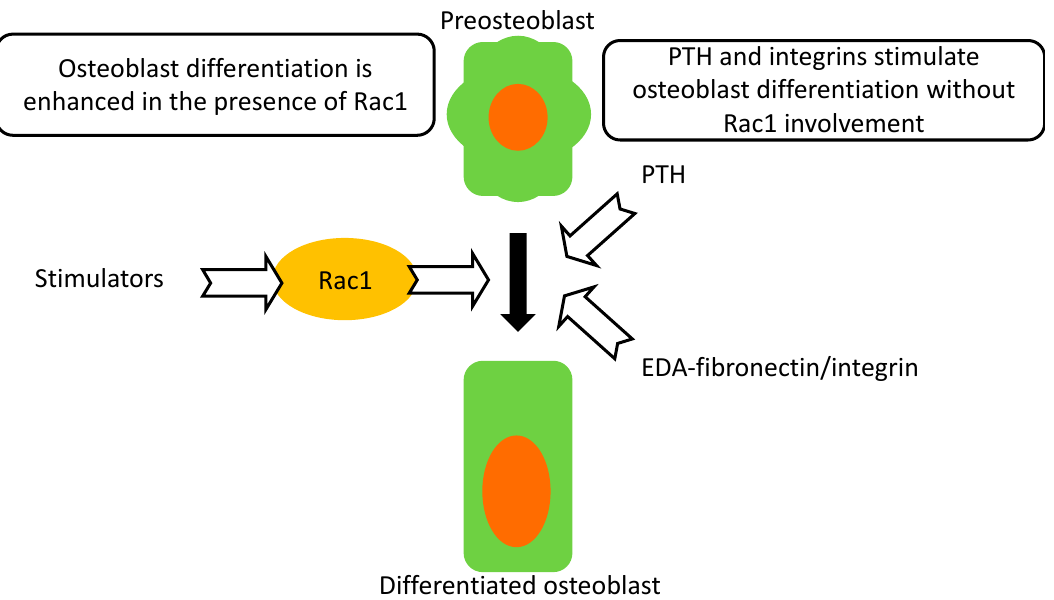
Figure 6. Summary. Osteoblast di ff erentiation proceeds normally in the presence of Rac1. Rac1, Figure 6. Summary . Osteoblast differentiation proceeds normally in the presence of Rac1. Rac1, however, is not required for intermittent PTH anabolic e ff ects. EDA-fibronectin-mediated enhancement of di ff erentiation through activation of α 4 β 1 can also proceed in the absence of Rac1. Thus, Rac1 is a modulator of di ff erentiation but is not an absolute requirement for di ff erentiation to